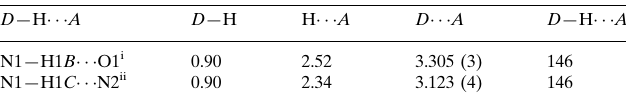
Hydrogen-bond geometry (A˚ , (cid:1)